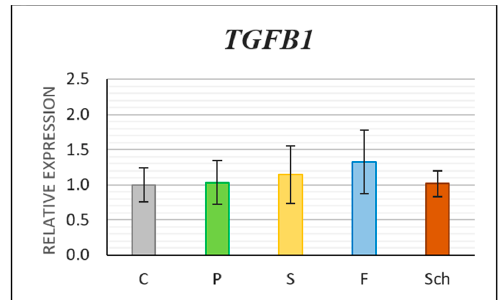
Figure 9. Relative gene expression of Transforming Growth Factor β 1 ( TGFB1 ). Control (C), palm oil (P), safflower oil (S), fish oil (F), and Schizochytrium extract (Sch) treated animals were analyzed 12 days after skin excision. Average values and standard deviations are displayed in the graph.